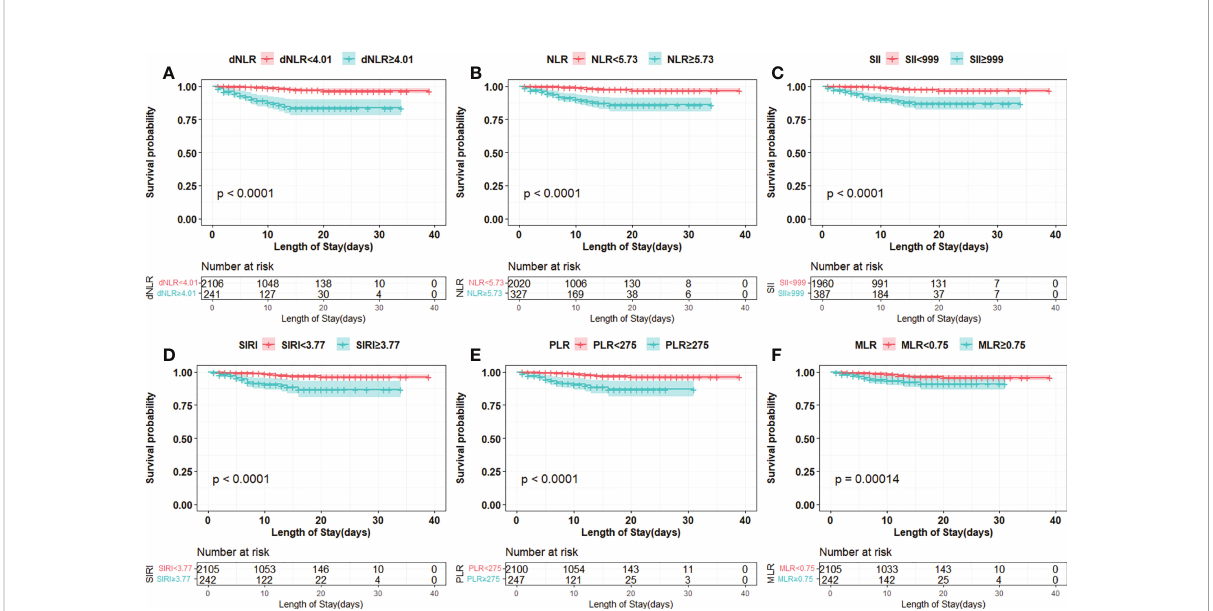
FIGURE 2 Kaplan-Meier curves of in fl ammation indicators in COVID-19 Omicron BA.2 infected patients. (A – F) Kaplan-Meier curves of six in fl ammation indicators. (A) Derived neutrophil to lymphocyte ratio (dNLR), (B) neutrophil to lymphocyte ratio (NLR), (C) systemic immune-in fl ammation index (SII), (D) systemic in fl ammation response index (SIRI), (E) platelet to lymphocyte ratio (PLR), (F) monocyte to lymphocyte ratio (MLR).